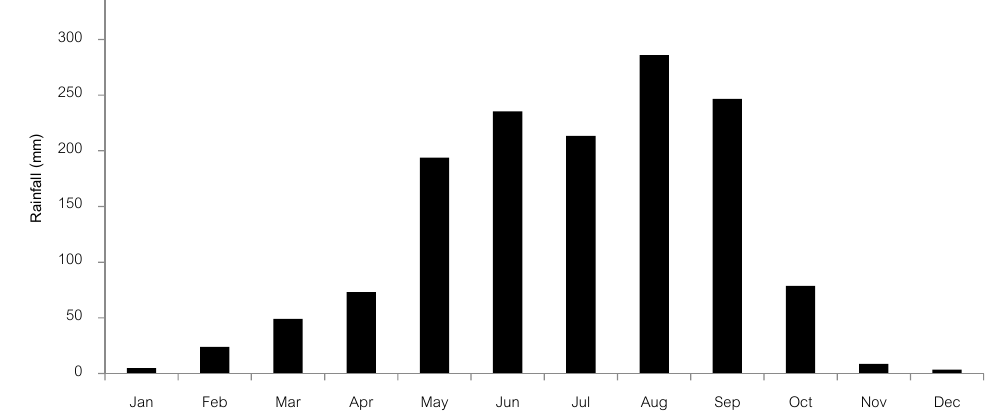
Figure 3. Observed climate data in the study area during 1981–2010.